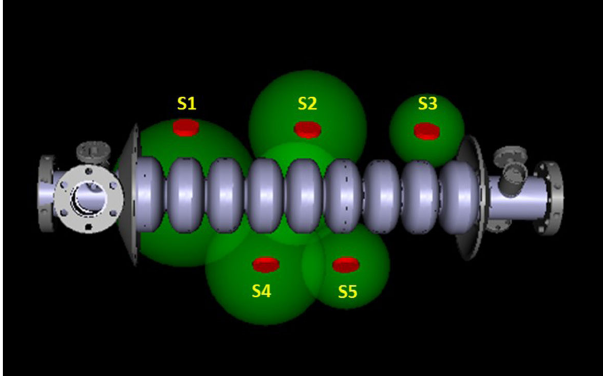
FIG. 4. Reconstruction of second sound signals for cavity 3HZ017. The spheres represent the quench detection range of the